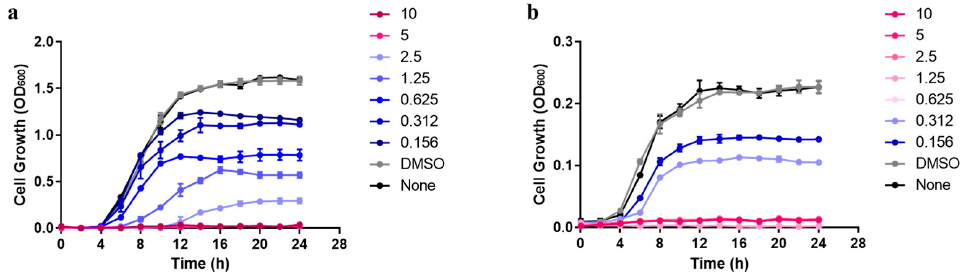
Figure 1. Minimal Inhibitory Concentration (MIC) of carvacrol against planktonic cells of P. aeruginosa ( a ) (5 mg mL − 1 ) and E. faecalis ( b ) (0.625 mg mL − 1 ). Bacterial turbidity was measured at OD600 nm using a spectrophotometer at intervals of 2 h over a 24 h incubation period with different concentrations of carvacrol in three independent experiments. Control containing DMSO was used.